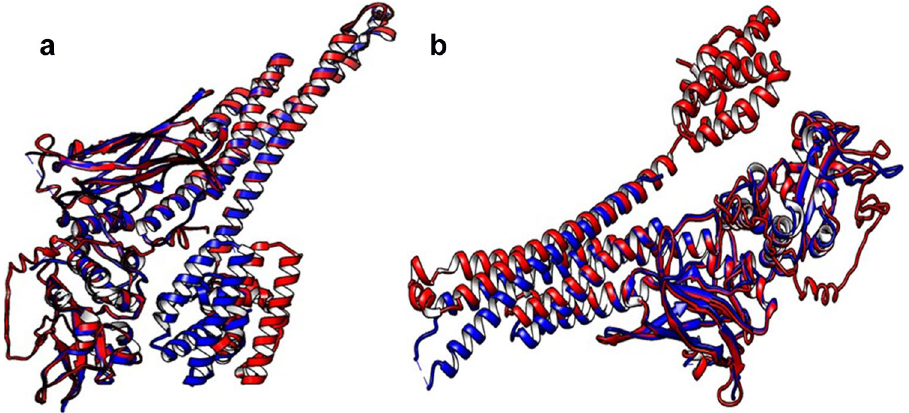
Figure 1. ( a ) I-TASSER-generated human STAT3α structure (in blue) modeled and superimposed on human STAT1 (PDB ID: 1YVL, in red) ( b ) I-TASSER-generated human STAT3α full-length structure (in red) with NTD included, superimposed on STAT3 (in blue) with PDB ID: 6TLC, which does not include